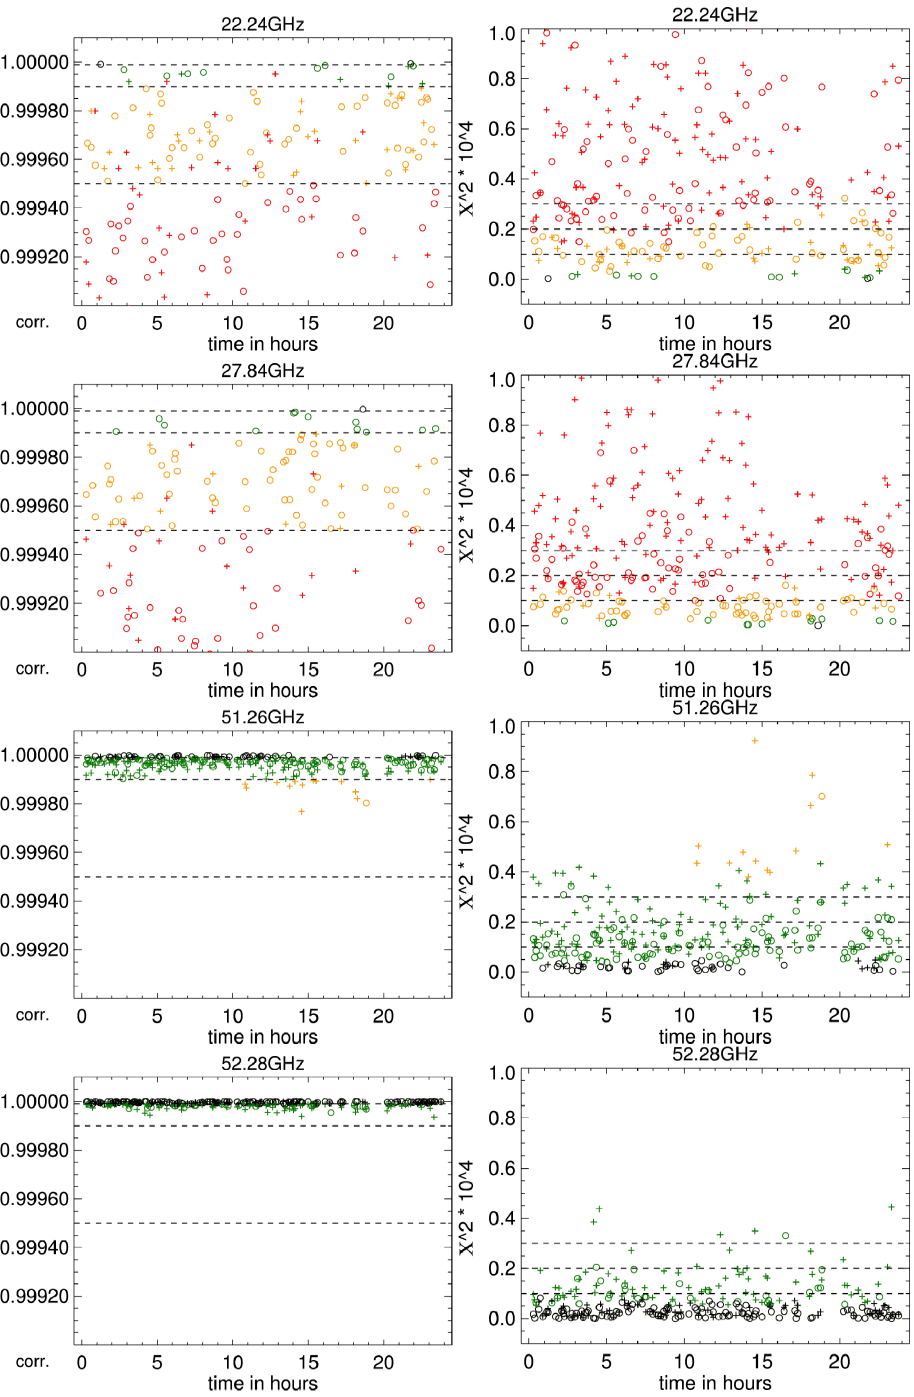
Fig. 9. Linear opacity–air mass correlations and χ 2 values for tipping curves on 16 August 2009 for selected HATPRO-G2 channels. Crosses: scans towards 70 ◦ N, circles: scans towards 250 ◦ N, dashed lines: quality thresholds corr min and χ 2 =0.1 × 10 − 4 , red: failed tipping curves for corr < corr min =0.9995; tipping curve calibrations from successful elevation scans when only the correlation threshold is applied: green: corr min =0.9995, black: corr min